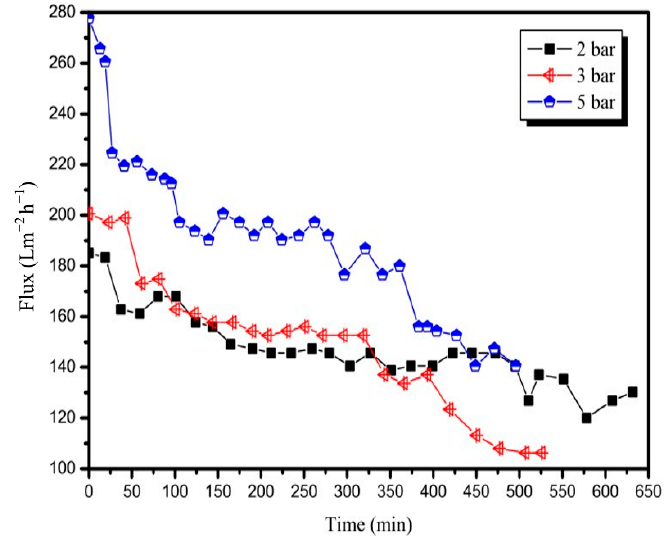
Figure 3. Variation in permeate flux with time for the 20 nm membrane at different TMPs (T = 90 °C, CFV = 3 m/s).